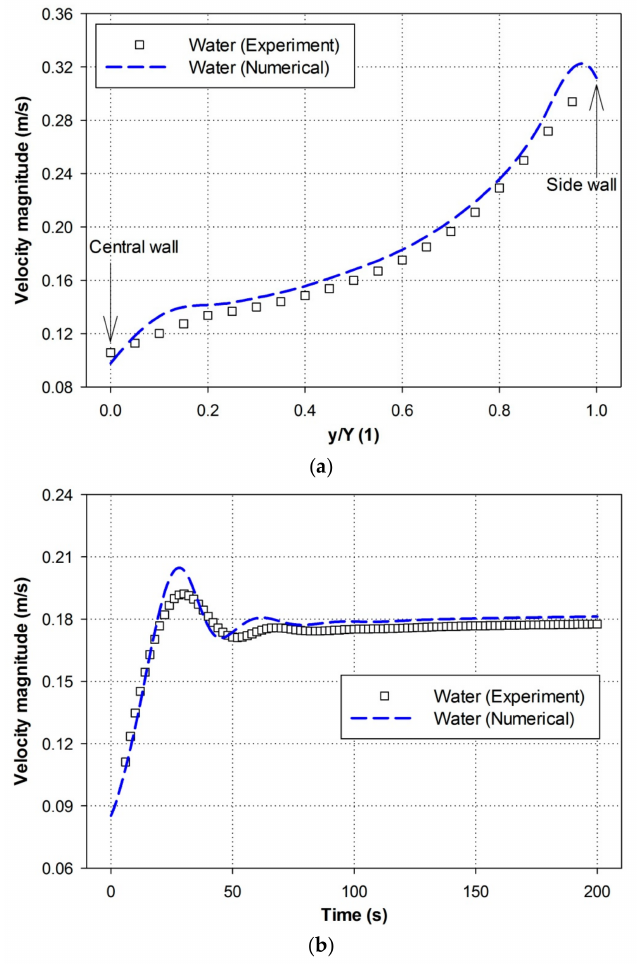
Figure 3. Comparison of experimental and CFD results on velocity magnitude